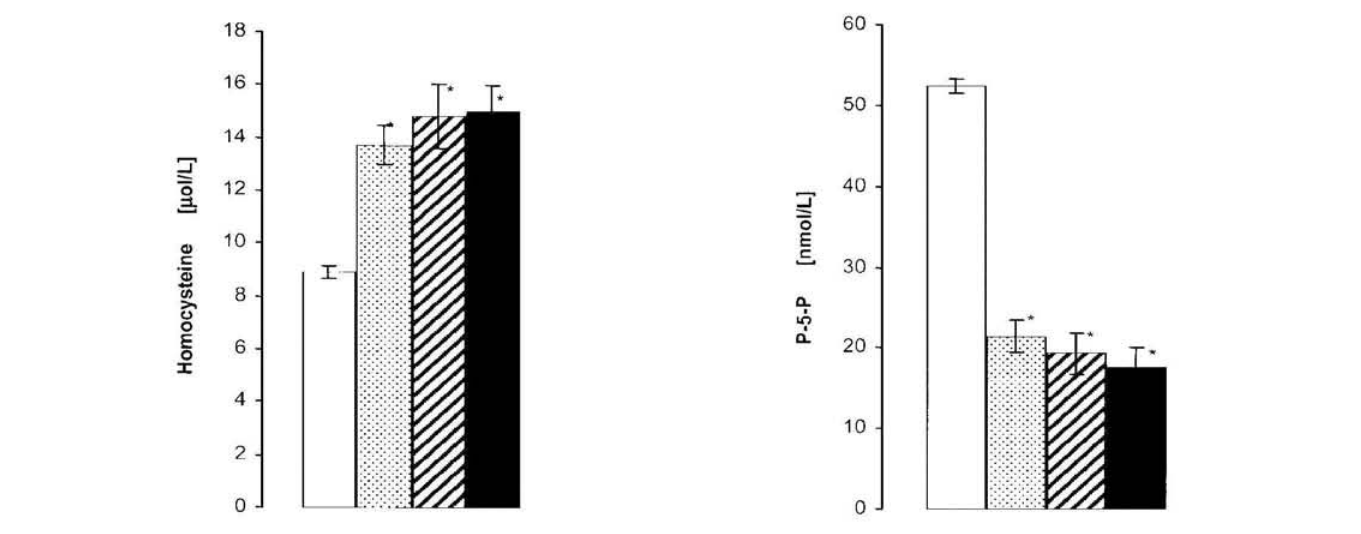
Figure 4. Scrum concentration (mean ± S.E.M.) of pyridoxal -5-phosphate in healthy individuals (open bars) and in C AD patients before percutaneous trans- luminal coronary angioplasty due to I-artery disease (dotted bars). 2- or 3-artery disease (hatched bars), and restenosis (black bars). * The changes are significant if compared with healthy individuals (P